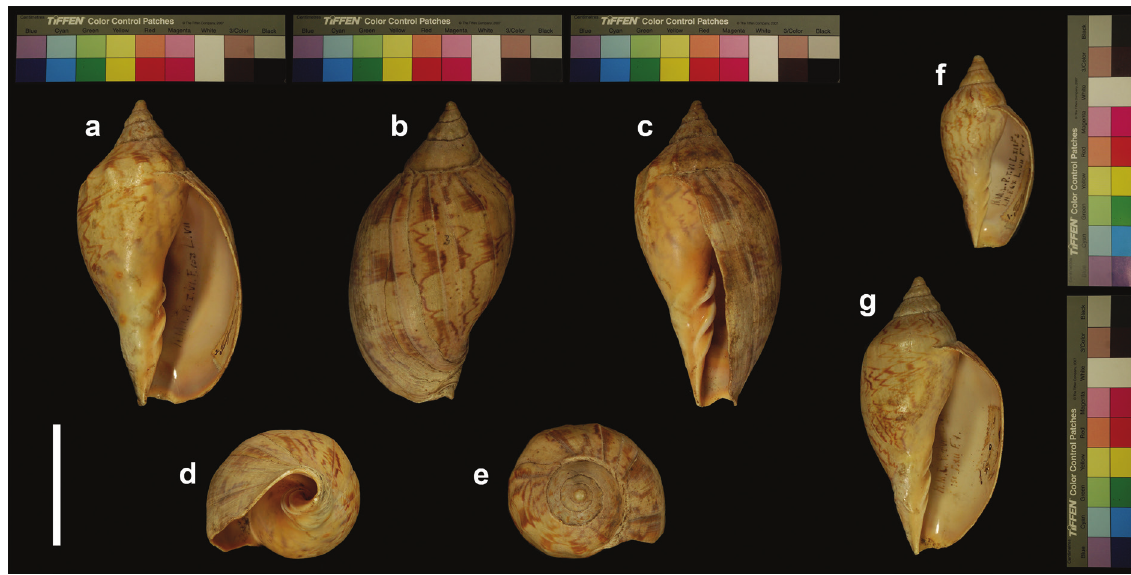
Figure 53. Voluta tuberculata fulgurea . a–e Specimen figured by Lahille (1895: pl. VII, fig. 153) a Apertural view b Dorsal view c Lateral view d Umbilical view e Apical view f Specimen figured by Lahille (1895: pl. VII, fig. 141; pl. XII, fig. 2; pl. II, fig. 67) in apertural view g Specimen figured by Lahille (1895: pl. VII, fig. 150; pl. XII, fig. 1). Scale bar: 5 cm.